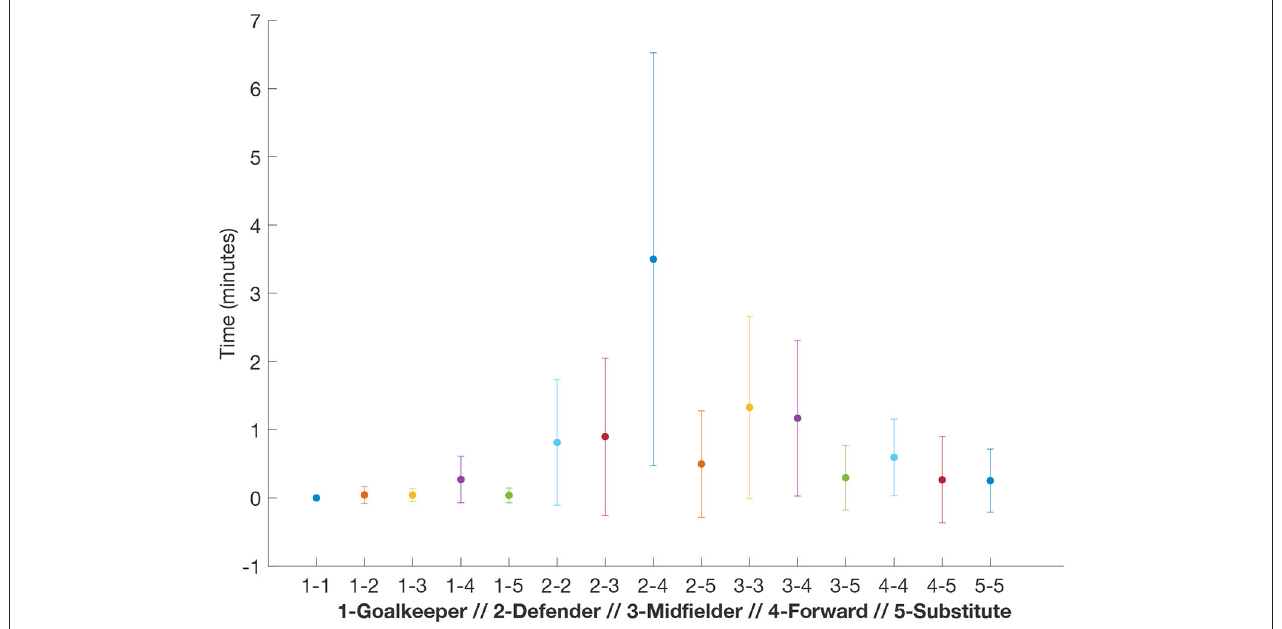
FIGURE 6 | Interaction between player positions. Average contact time according to the position of a player and the opponent. Error bars correspond to the standard deviation. We can observe how the interactions between defenders and forwards accumulated the highest contact time, followed by the interactions between midfielders. On the other side, goalkeepers are those players that interact the least, with a contact time equal to zero with the opponent goalkeepers and the highest value with opponent forwards.